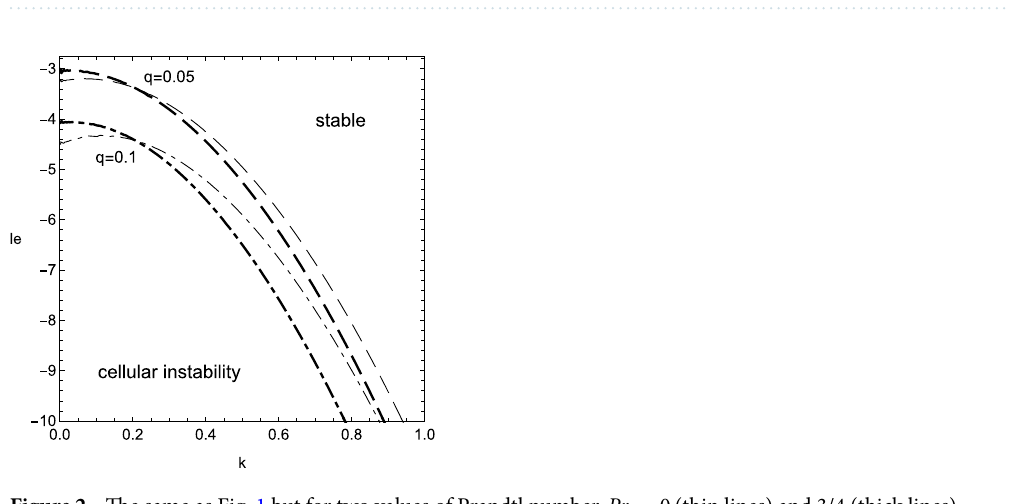
0 (solid line), 0.05 = 0 . 10 and Pr = =